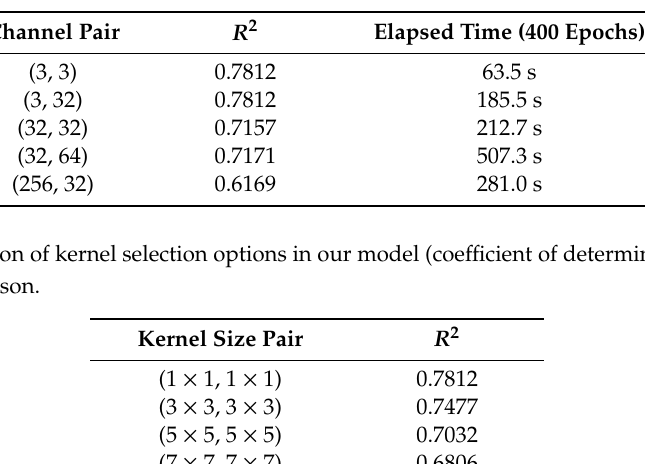
Table 5. Comparison of channel selection options in our model (coe ffi cient of determination, R 2 ).